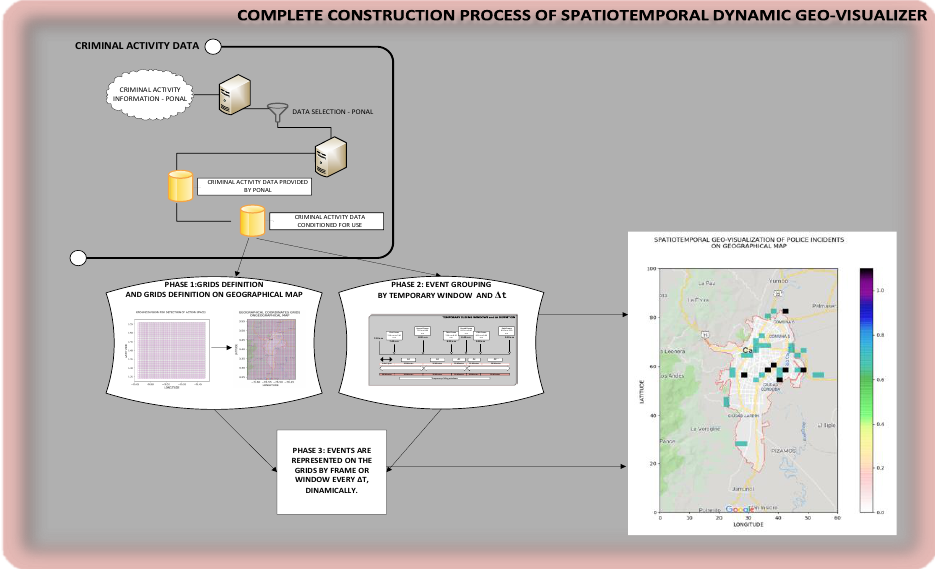
Figure 7. Graphic of the complete process of the Spatiotemporal Dynamic Geo-visualization of data on geographical map, for C2S criminal data on geographical map, for C2S applications.